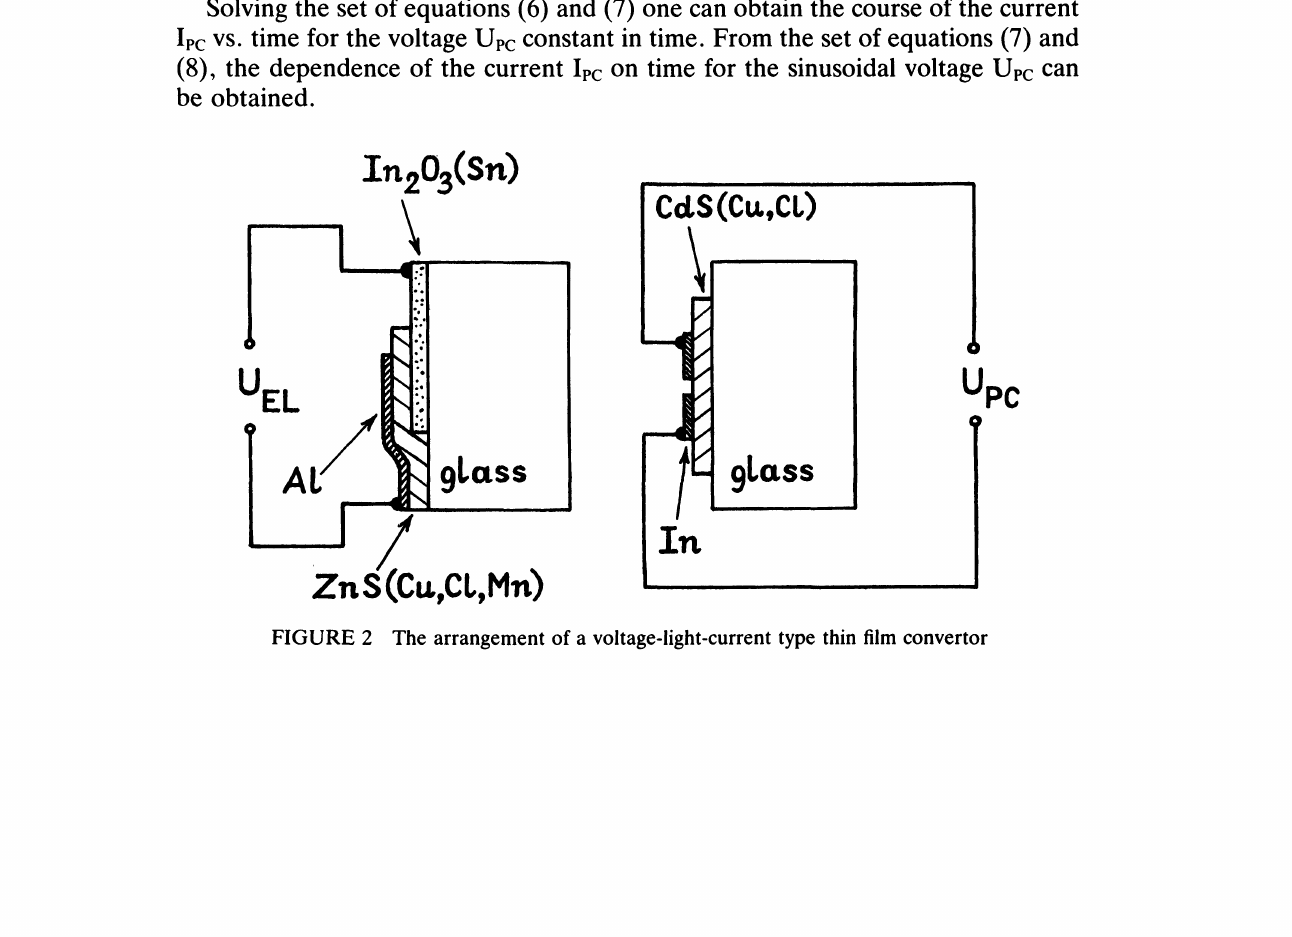
FIGURE 2 The arrangement of a voltage-light-current type thin film